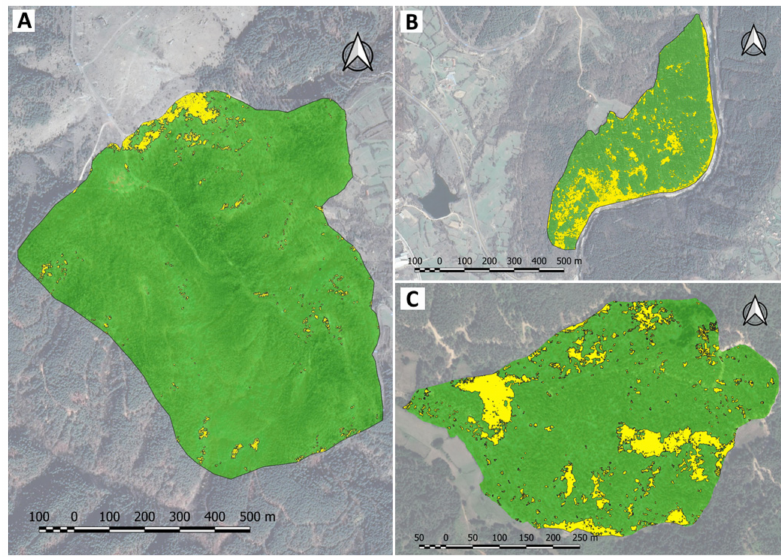
Figure 8. Bark beetle spots in studied areas (in yellow colour): ( A ) Fotinovo; ( B ) Kirkovo; ( C )